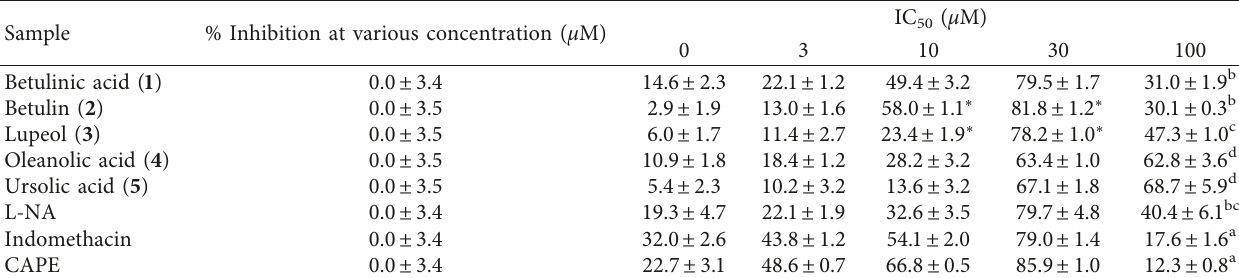
Table 3: Anti-inflammatory activity of isolated compounds from B. alnoides in